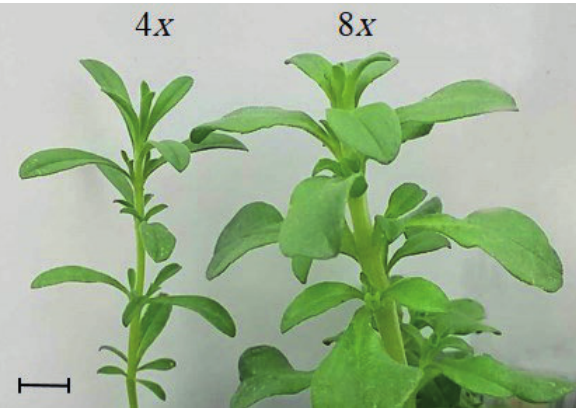
Figure 4. Comparison of the morphology between tetraploid (a) and octaploid (b) S. mutica . Bars = 5 mm.